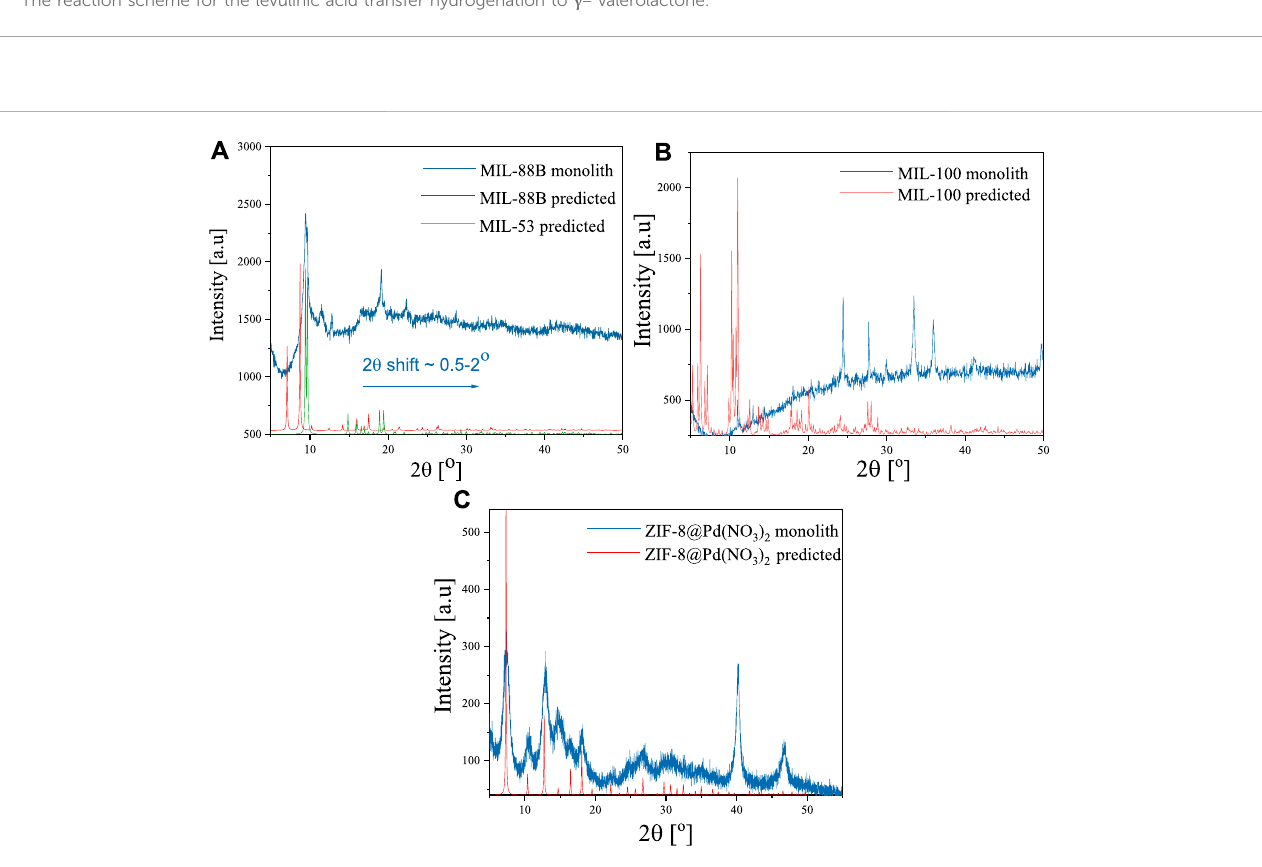
FIGURE 2 Experimental and predicted XRD spectra for monolithic (A) MIL-88B (Fe), (B) MIL-100 (Fe), and (C) ZIF-8@Pd(NO 3 ) 2.